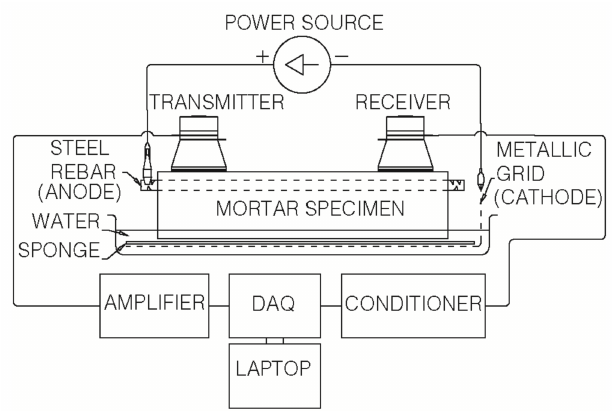
Figure 3. Schematic representation of the setup of the forced corrosion tests, also showing the system that is used for performing non-linear ultrasonic